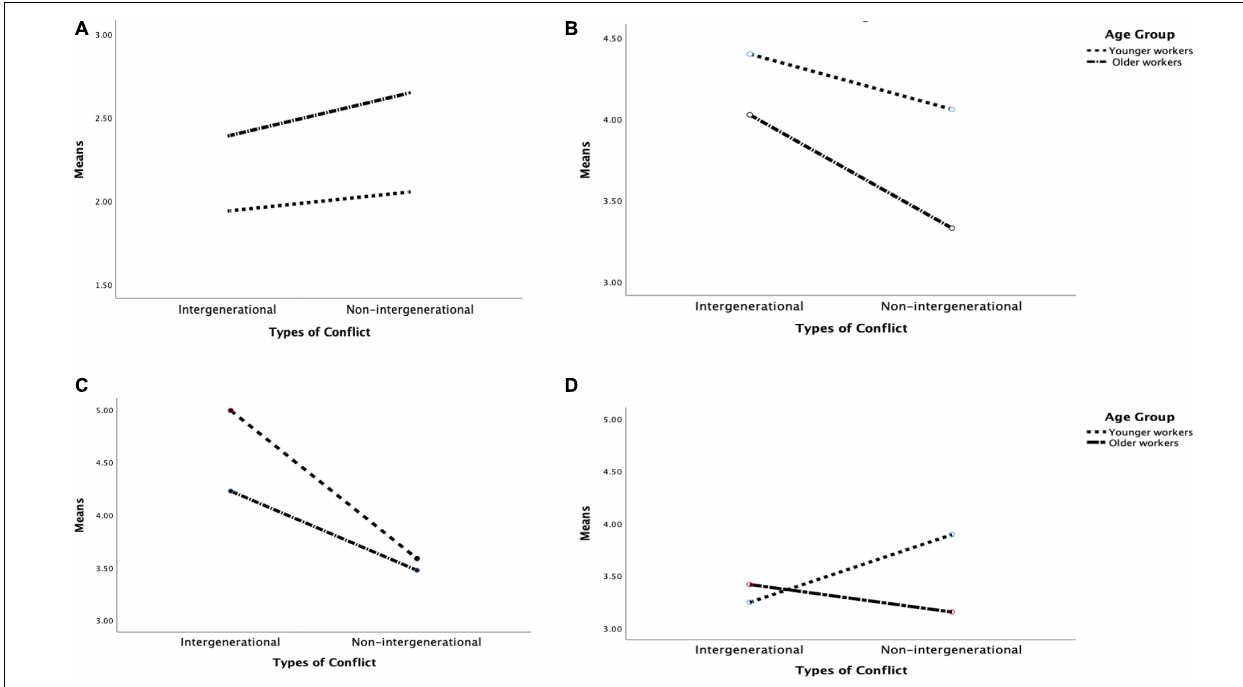
FIGURE 1 | Interaction effects between conflict type and age group on emotions and conflict strategies. (A) Positive Emotions; (B) Negative Emotions; (C) Dominating; and (D)